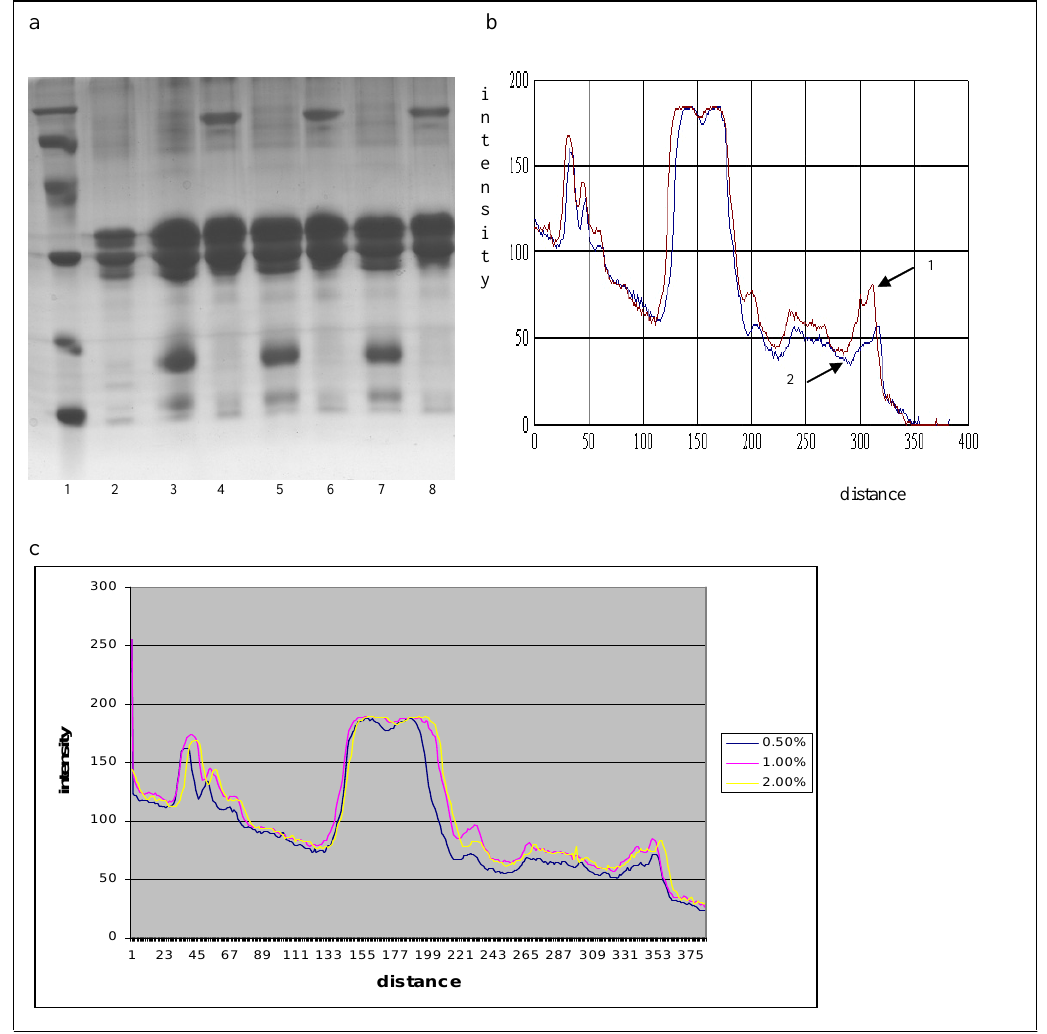
Figure 7 . The electrophoretic* and the comparative densitometric analysis of the reconstituted skim milk with the demineralized whey added, treated at 90 °C for 20 minutes. a. The electrophoretic analysis of the reconstituted milk with 0.5% (7, 8), 1.0% (5, 6), and 2.0% (3, 4) of demineralized whey added; molecular weight standards (1) and Na-caseinate (2). b. The comparative densitometric analysis of the heat treated samples, treated without (-) and with (-) 0.5% of the demineralized whey. c. The comparative densitometric analysis of the samples treated with 0.5%, 1% and 2.0% of the demineralized whey